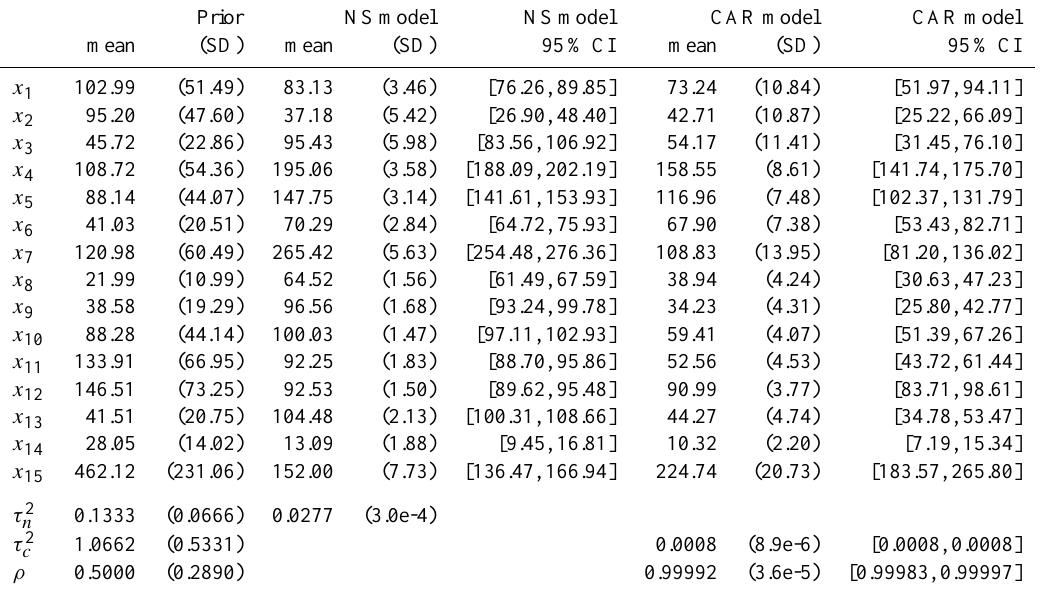
Fig. 8. Plots as in Fig. 7, now based on L = 1000, 2000, and 5000km. Table 2. Summary of posterior inferences for the CO fluxes (in units of TgCOyr − 1 ) and model parameters from analysis of actual MOPITT retrieval data. See Fig. 2 for definition of source category